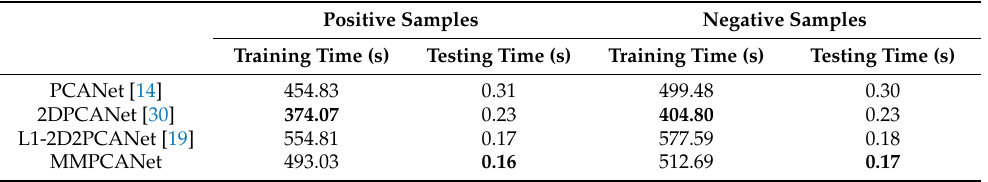
Table 4. Performance on CelebA